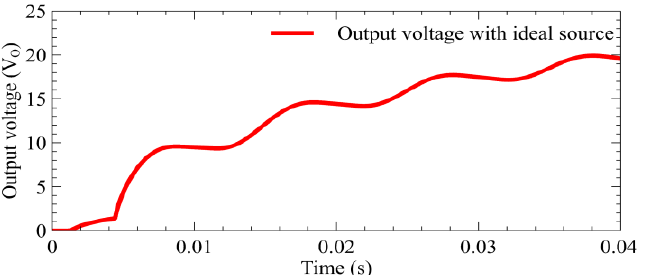
Figure 10. Stored output voltage load capacitor, C L2 , as a consequence of Modes 1 – 6.